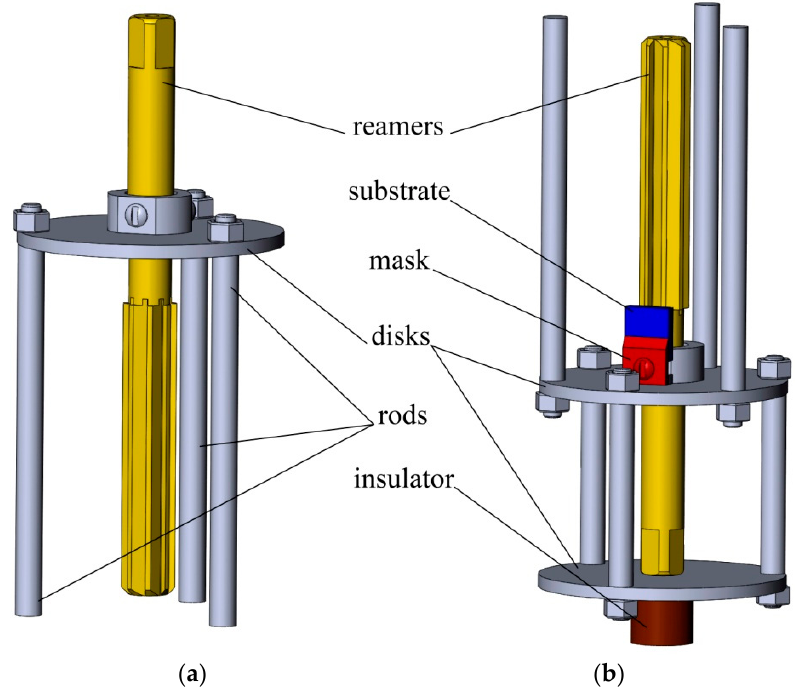
Figure 2. Two parts of the reamer holder: ( a ) an upper part; ( b ) a lower part.